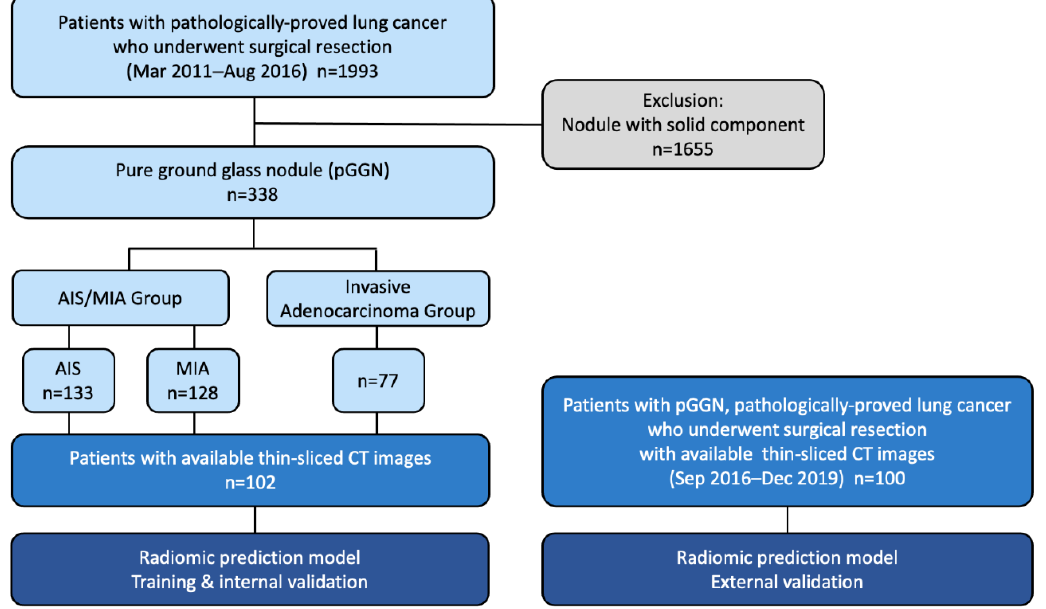
Figure 1. Flowchart of the study